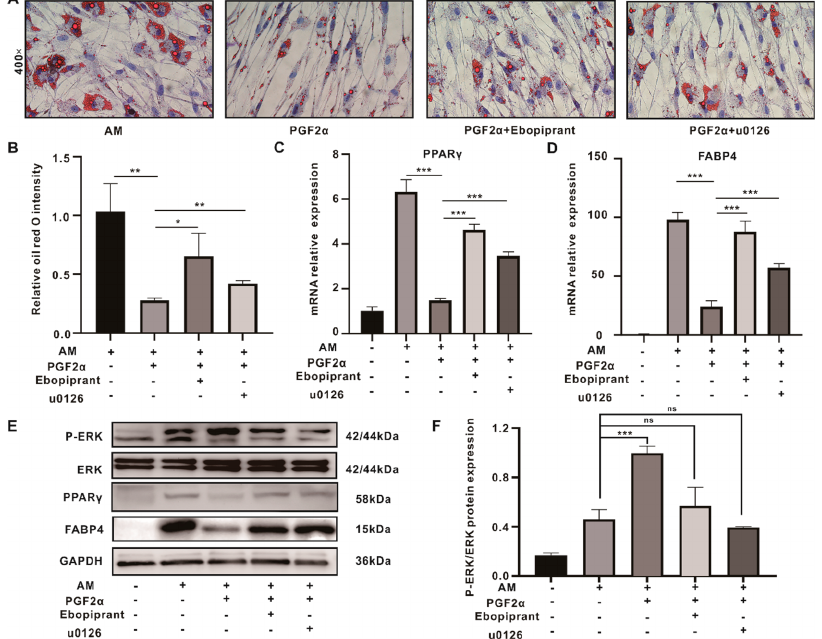
Figure 5. PGF2 α regulates the FPR/ERK pathway during OFs adipogenesis inhibition. ( A ) The oil red O staining assays for the induced, PGF2 α , Ebopiprant + PGF2 α , and U0126 + PGF2 α groups. ( B ) The quantitative data from ( A ). ( C , D ) The mRNA levels of PPAR γ and FABP4 in the control, induced, PGF2 α , Ebopiprant + PGF2 α , and U0126 + PGF2 α groups. ( E ) The WB results of PPAR γ and FABP4 for each group; ( F ) The degree of the P-ERK/ERK protein expression from ( E ). Data are presented as the means ± SEMs ( n = 3) (*, p -value < 0.05; **, p -value < 0.01; ***, p -value < 0.001). AM: adipogenesis induction medium. ns = not